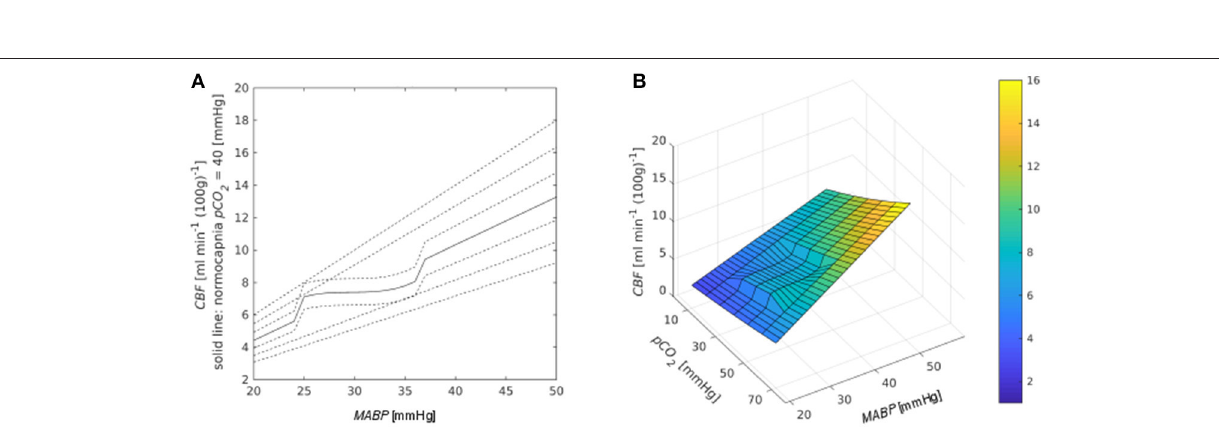
FIGURE 3 | (A) Dependence of CBF on MABP . The platea occurs around MABP ref = 30 mmHg. Different lines correspond to different values of pCO 2 in mmHg [from bottom to top: 10, 20, 30, 40 (solid line corresponds to normocapnia), 50, 60, 70]. (B) Combined effect of MABP and pCO 2 on CBF .